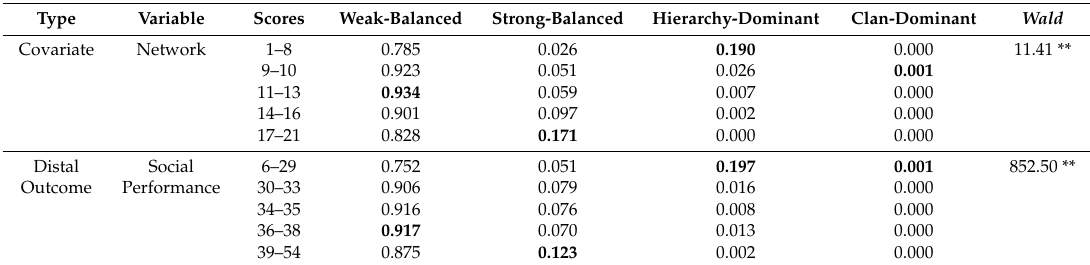
Table 5. Multinomial regression presenting associations between latent profile membership and external variables (Second model: social